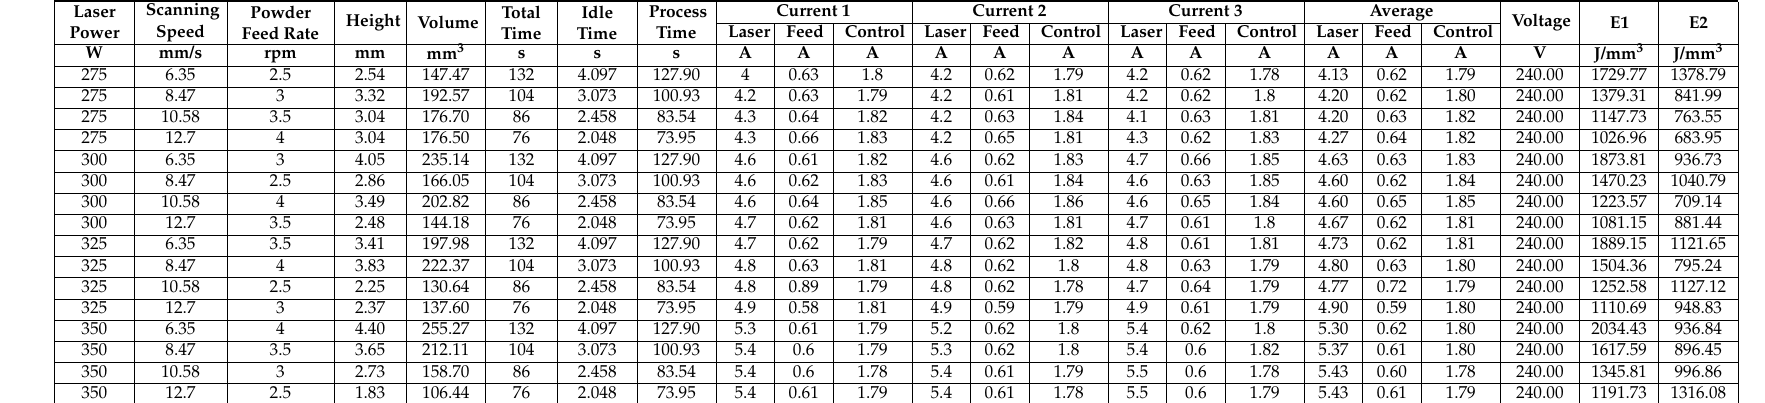
Table 3. Results of the block volume, process time, currents measured, as well as energy consumption versus parameters combinations. Laser